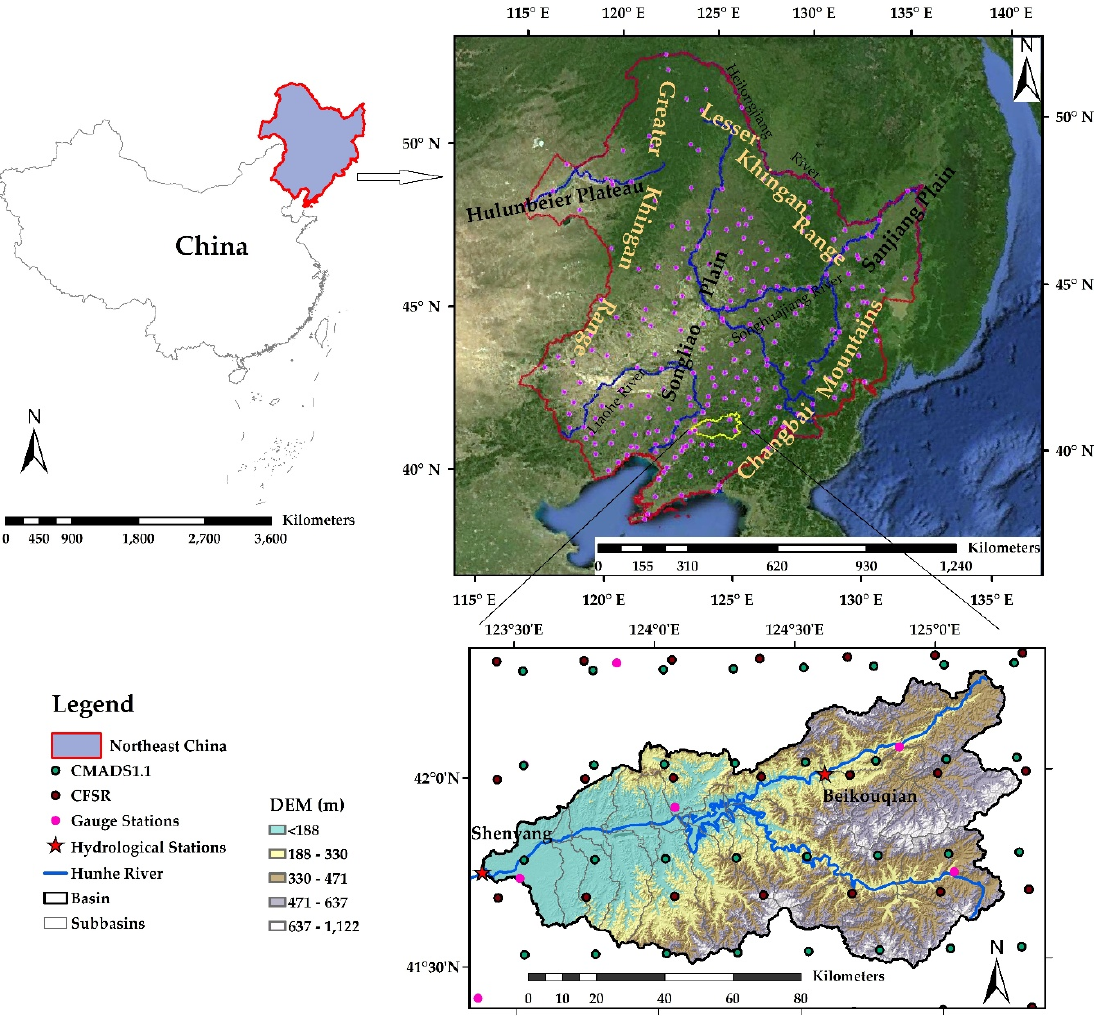
Figure 1. Location of study area. Marks: DEM refers to the digital elevation model; CMADS 1.1 and CFSR refer to the China Meteorological Assimilation Driving Datasets for the Soil and Water Assessment Tool model (Version 1.1) and Climate Forecast System Reanalysis, respectively; and some examples from three meteorological products covering the Hunhe River Basin are shown for intuitive density comparison among them.